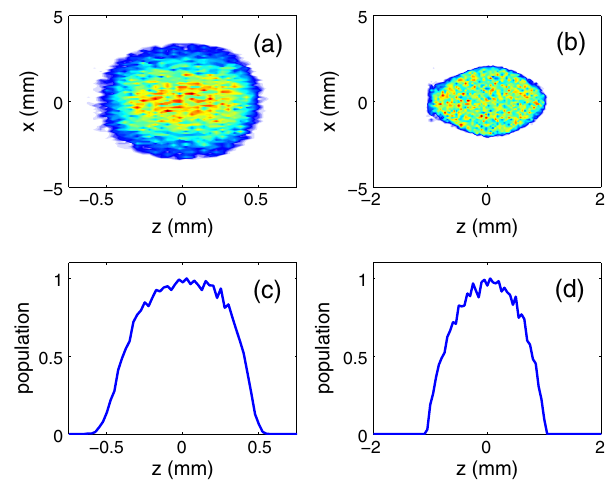
FIG. 6. Simulated spatiotemporal distribution ð z; x Þ (left col- umn) and associated longitudinal charge distribution (right col- umn) simulated at X3 ( s ¼ 3 : 77 m ) for three cases of charges 100 [(a), (b)], 250 [(c), (d)], and 1000 pC [(e), (f)]. In these plots the tail of the bunch is at z > 0 . Plot (g) illustrates the rms bunch length evolution along the beam line up to z ¼ 3 : 77 m (location of X3) for the three cases of bunch charge. The shaded area in plot (g) indicates the location of the booster cavity. The rms laser transverse size is kept constant to (cid:2) c ¼ 1 mm for the three cases of